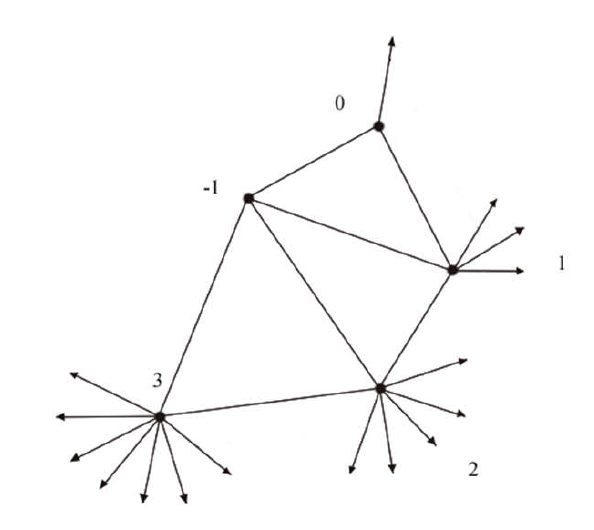
Figure 3. The Quantum Growing Network